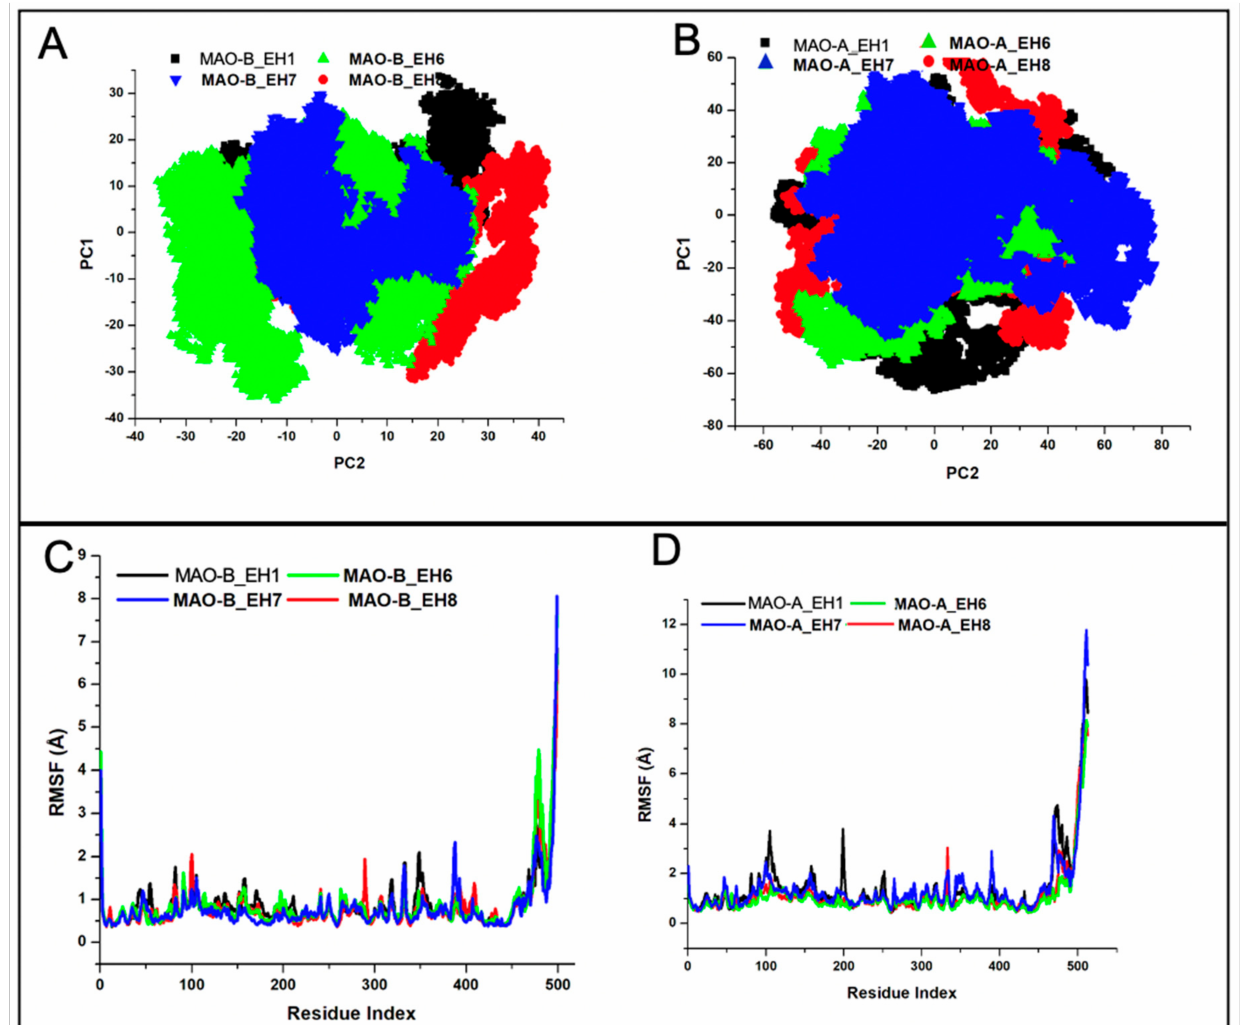
Figure 7. Principal component analysis of the compounds bound to MAO-B ( A ) and to MAO-A ( B ), and root mean square fluctuation (RMSF) of the compounds bound to MAO-B ( C ) and to MAO-A ( D ). ( A , B ) EH1 , black; EH6 , green; EH7 , blue; and EH8 , red. ( C , D ) EH1 , black; EH6 , green; EH7 , blue; and EH8 ,